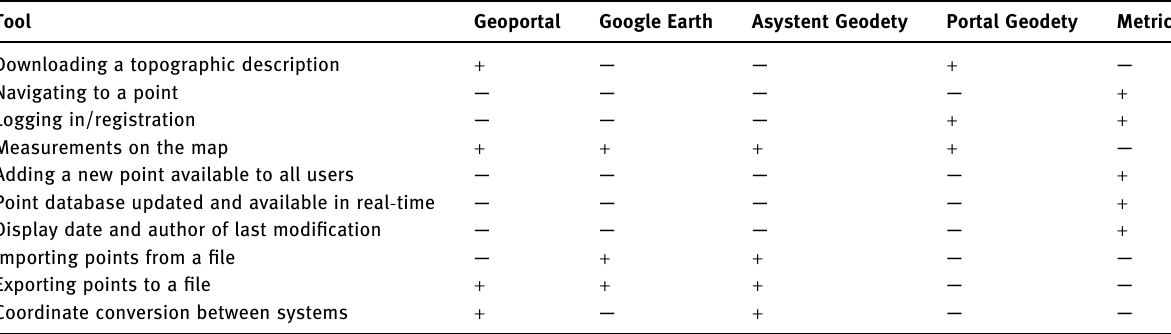
Table 1: Comparison of the title application with existing tools Tool Geoportal Google Earth Asystent Geodety Portal Geodety